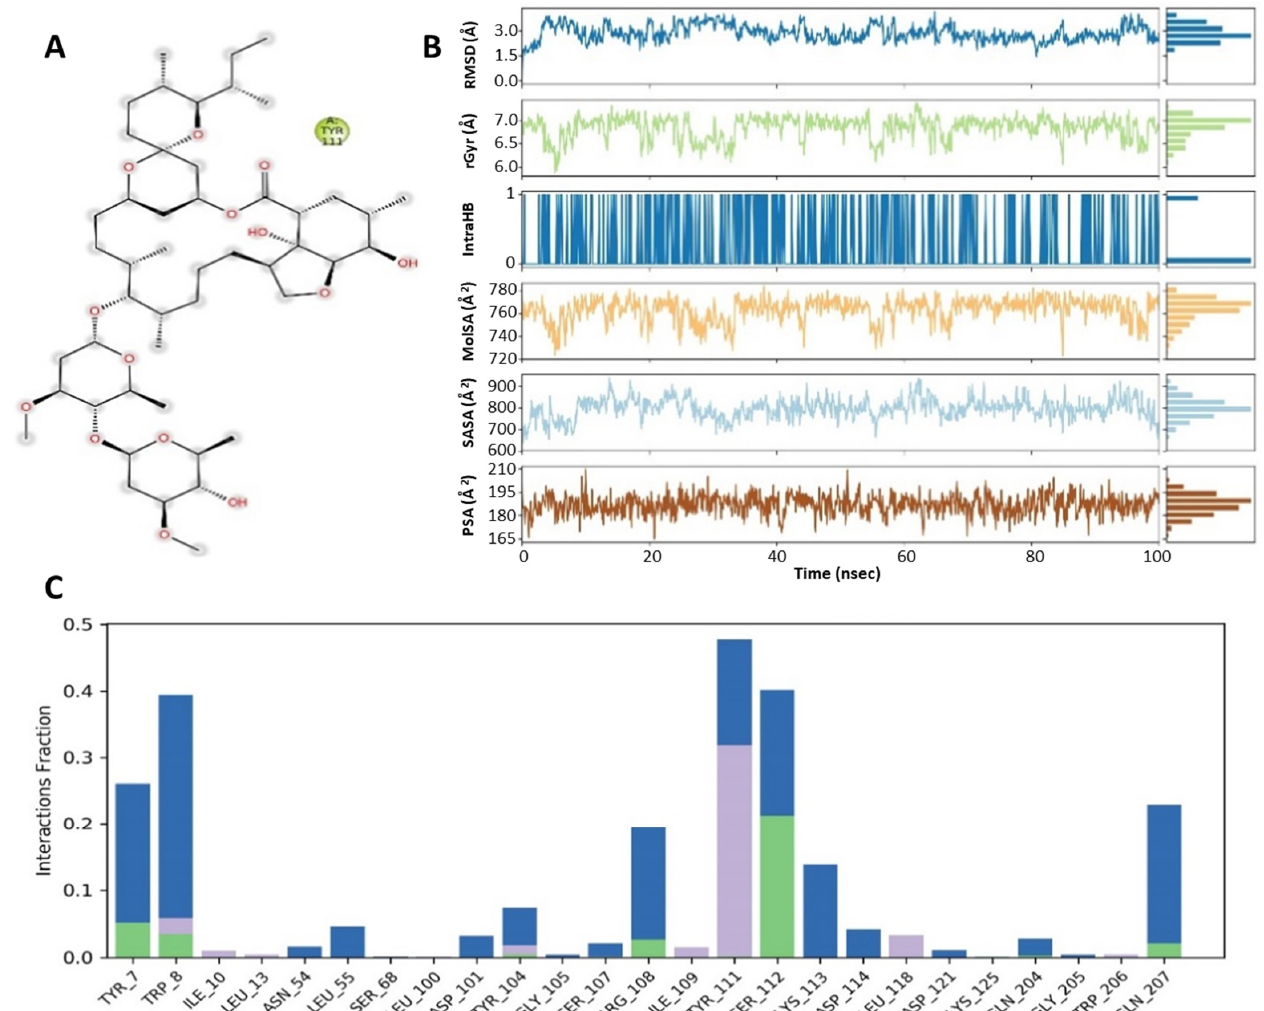
Figure 6. ( A ) Molecular interactions of ivermectin within the pockets of GST receptor at specific sites. ( B ) Demonstration of ivermectin properties as ligand against GST receptor. ( C ) A histogram displaying the different types of interactions within ivermectin–GST complex. The values of RMSD, radius of gyration, molecular surface area, solvent accessible surface area and polar surface area are peaked and represented by the blue line, green line, orange line, cyan blue line and brown line, respectively.